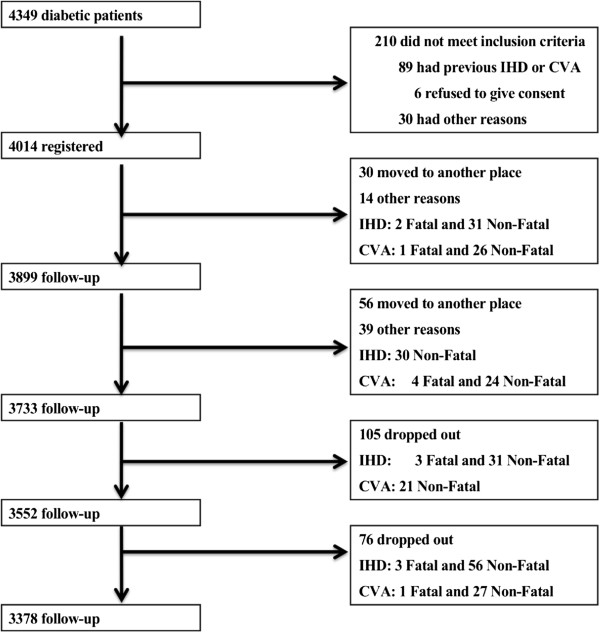
Study profile. “Months” indicates months after March 2005.